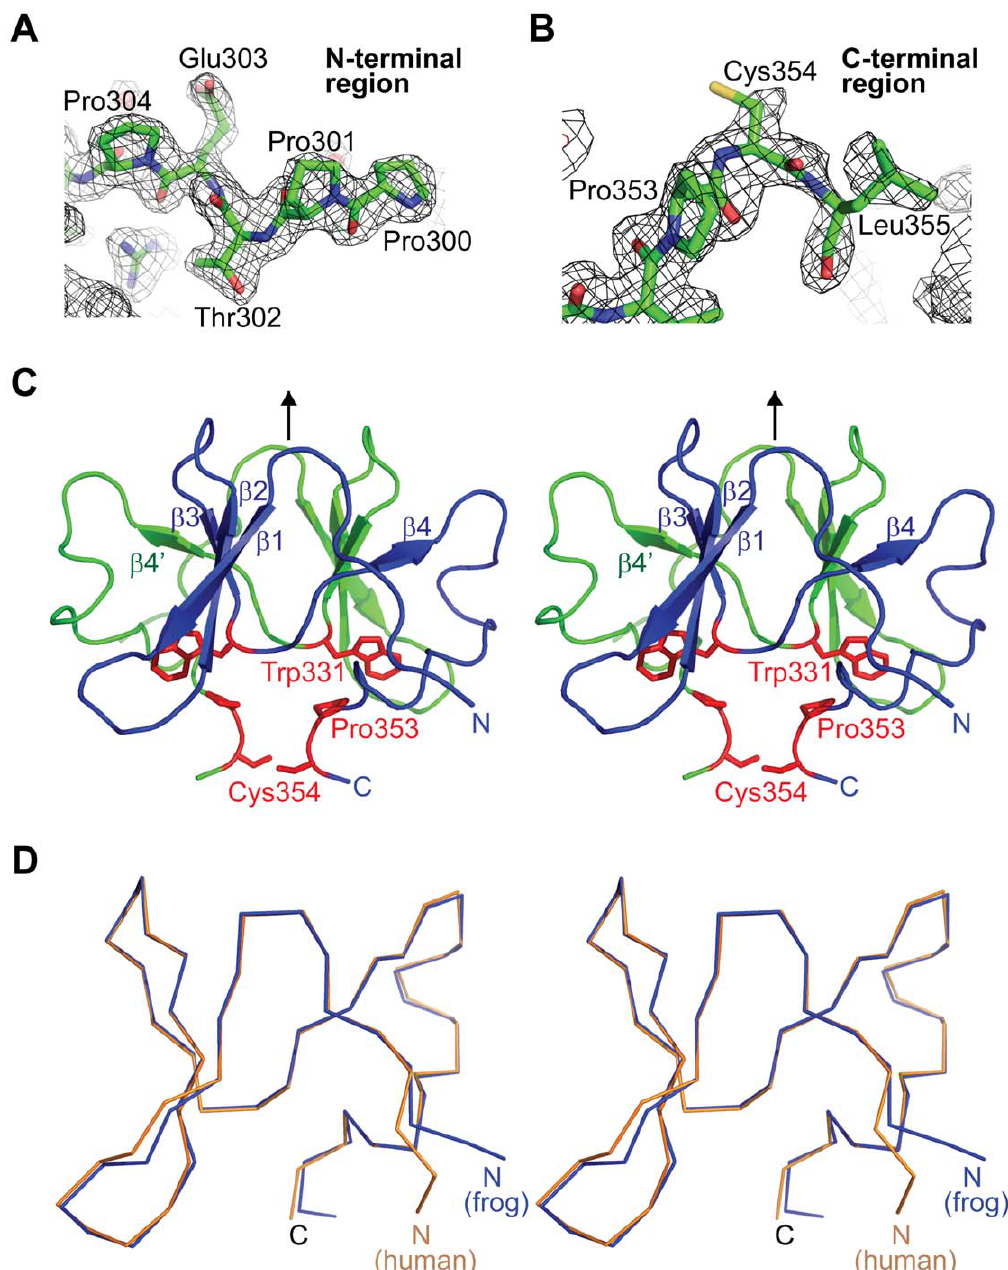
Figure 3. Crystal structure of the frog DGCR8 dimerization domain. (A–B) 2F o -F c electron density maps, contoured at 1 s level, of the N- and C-terminal regions of the frog dimerization domain, respectively. (C) Wall-eyed stereo diagram of the crystal structure of frog dimerization domain. The dimer subunits are colored green and blue. Secondary structures from the green subunit are denoted with a prime. The crystallographic two-fold axis relating the two subunits is indicated by the arrow. Residues known to be important for heme binding are highlighted in red. (D) Superimposition of human (orange) and frog (blue) dimerization domain C a traces shown in stereo.